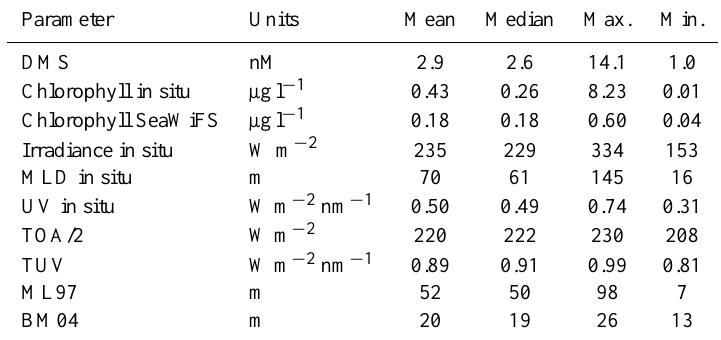
Table 1. A summary of cruise data, firstly the mean, median and range of measured DMS, in situ chlorophyll, SeaWiFS chlorophyll irradiance, mixed layer depth (MLD) and UV and secondly, from calculations or climatologies, the mean, median and range of estimated irradiance (TOA/2), UV (TUV) and the MLD from the ML97 and BM04 climatologies. Parameter Units Mean Median Max. Min. DMS nM Chlorophyll in situ µgl − 1 0.43 Chlorophyll SeaWiFS µgl −